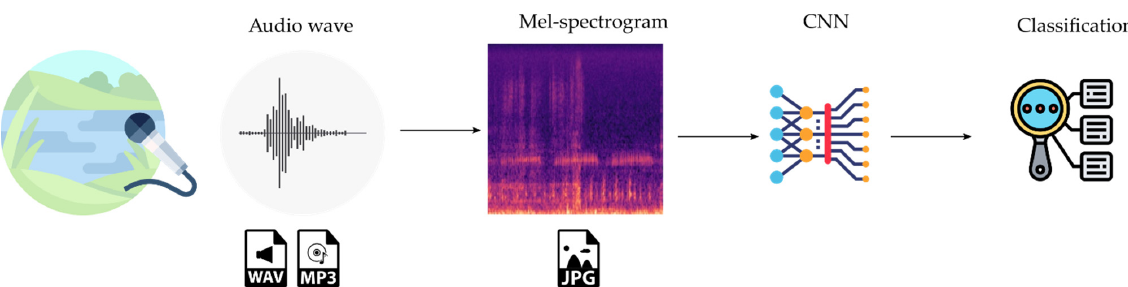
Figure 4. Stages in the CNN classification system.